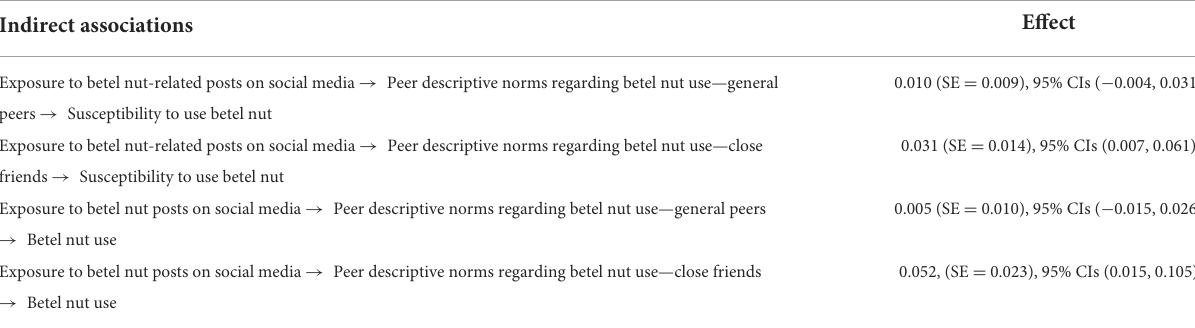
TABLE 6 Indirect associations between exposure to betel nut-related posts on social media and betel nut susceptibility and use through perceived descriptive peer norms. Indirect